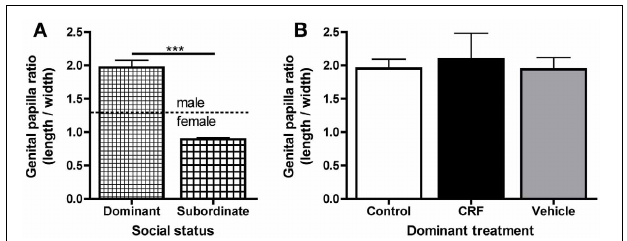
FIGURE 7 | Mean ( ± s.e.m.) genital papilla length-to-width ratio. (A) Dominant fish (control, CRF-injected, and vehicle-injected) had significantly higher genital papilla ratios than subordinate fish (Mann–Whitney U -test: U = 12 . 0, n dom = 25, n sub = 27, p < 0 . 0001). Dominant fish had male-typical length-to-width ratios (average 1 . 99 ± 0 . 11) and subordinates had female-typical ratios (average 0 . 89 ± 0 . 023). (B) There were no differences in genital papilla ratio among dominant control, CRF-injected, or vehicle-injected fish [one-way ANOVA: F ( 2 , 22 ) = 0 . 099, p = 0 . 91]. Similarly, there was no difference among subordinates (data not shown, one-way ANOVA: F ( 2 , 24 ) = 0 . 22, p = 0 . 81). Asterisks indicate significant differences ( p < 0 .